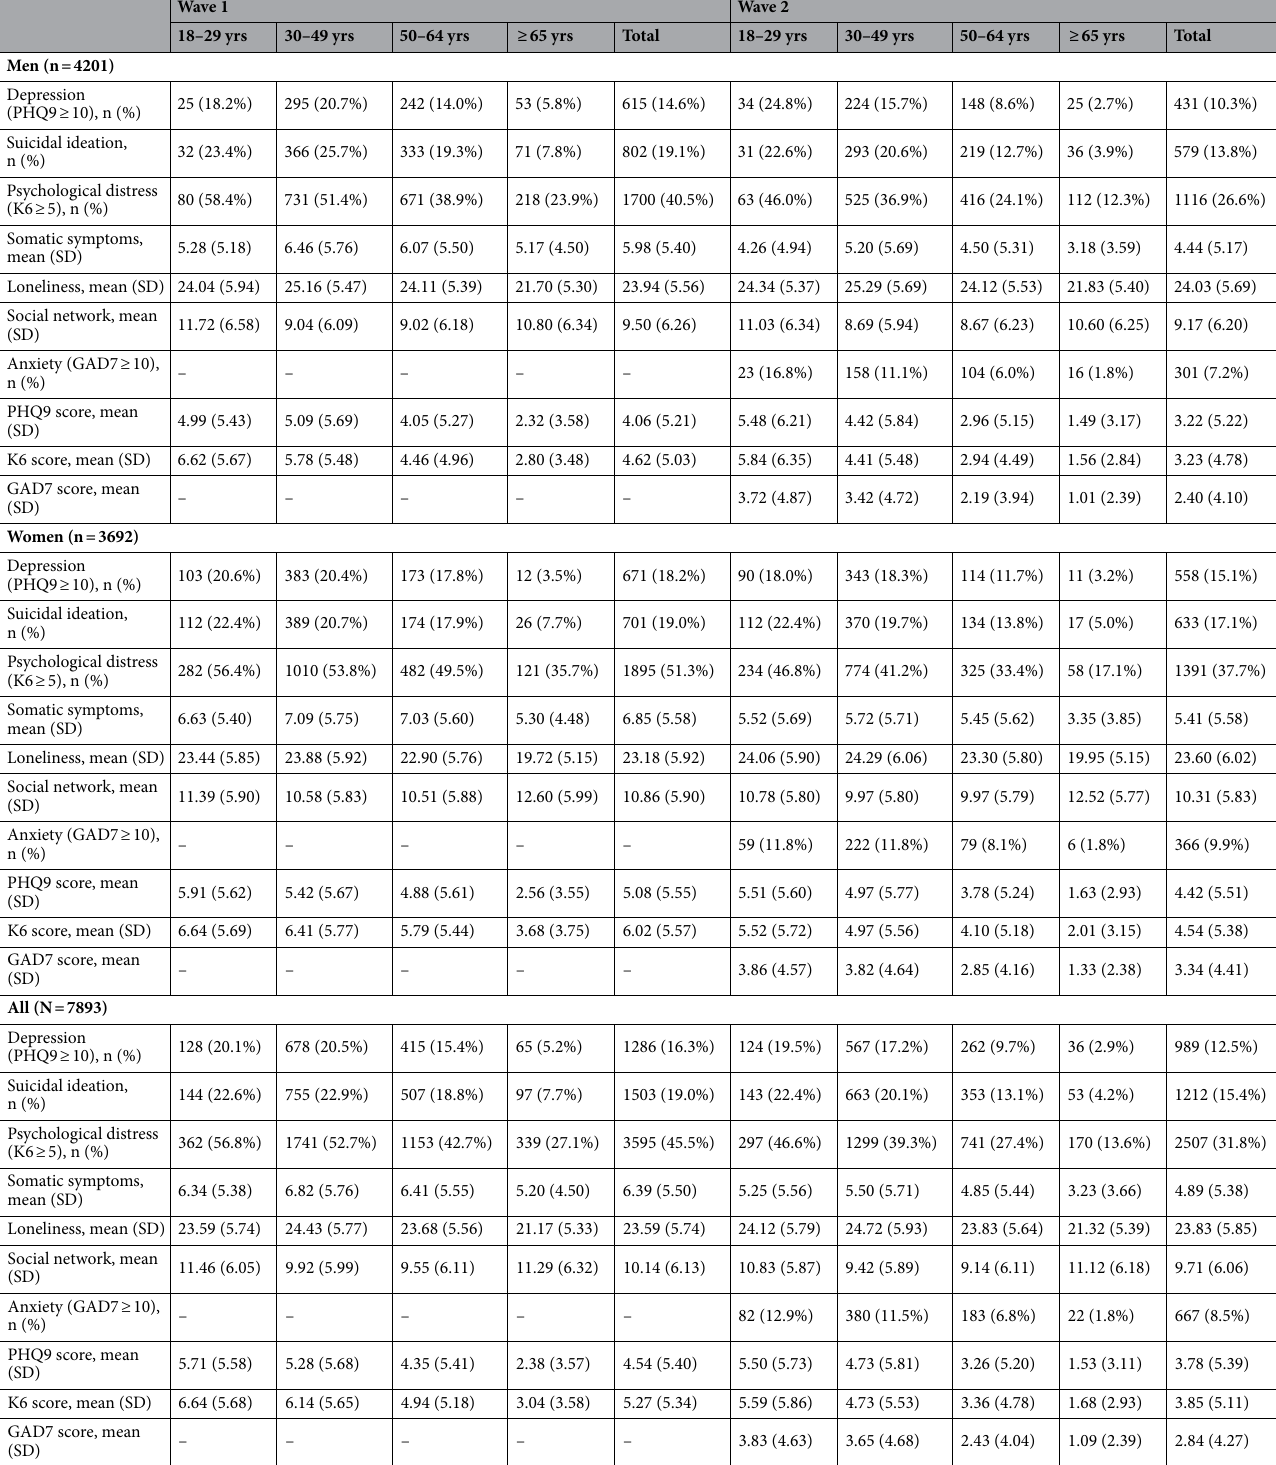
Table 3. Changes in outcome variables by age group and gender. PHQ9 Patient Health Questionnaire-9, K6 Kessler Psychological Distress Scale-6, GAD7 Generalized Anxiety Disorder